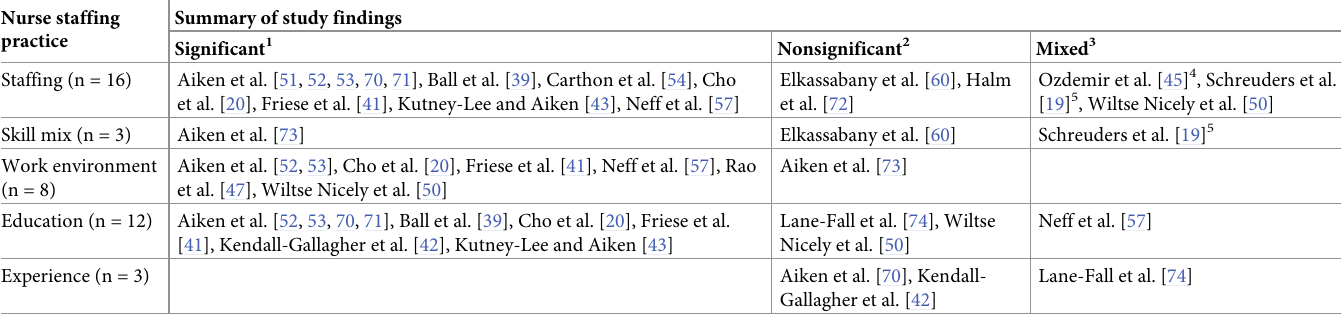
Table 4. Nurse staffing practices in association with 30-day